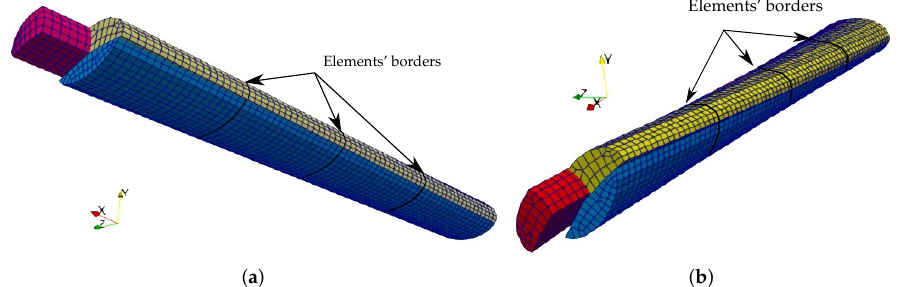
Figure 5. The deformed shapes of the pre-twisted Achilles tendons when the soleus is loaded and discretized by four ANCF-based continuum beam elements at each subtendon. ( a ) ψ = 15 ◦ ( b ) ψ = 45 ◦